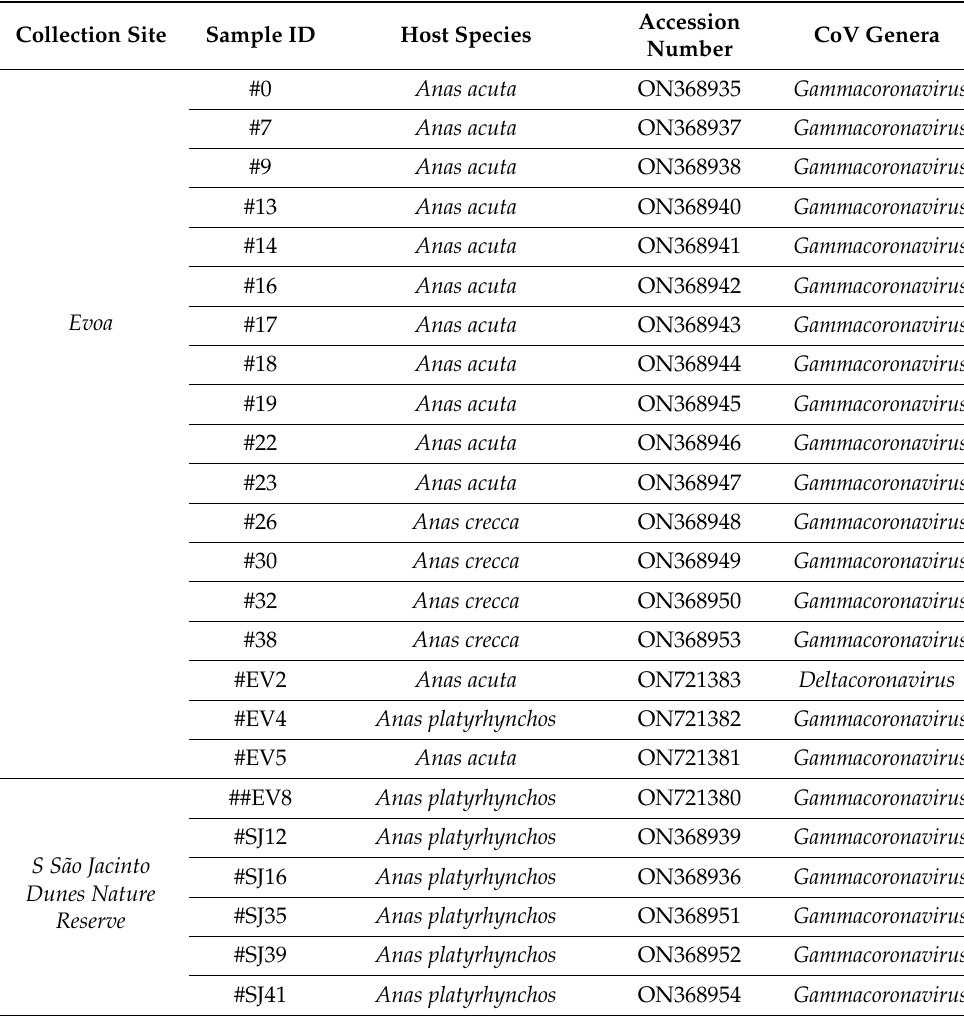
Table 1. Details of the samples from this